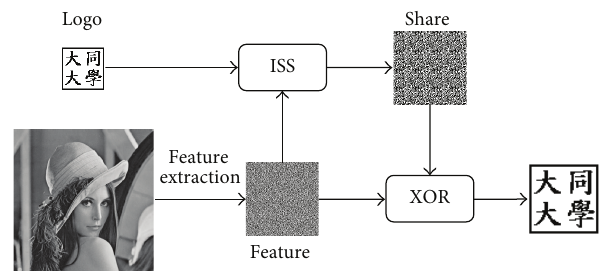
Figure 1: The process of the ISS.